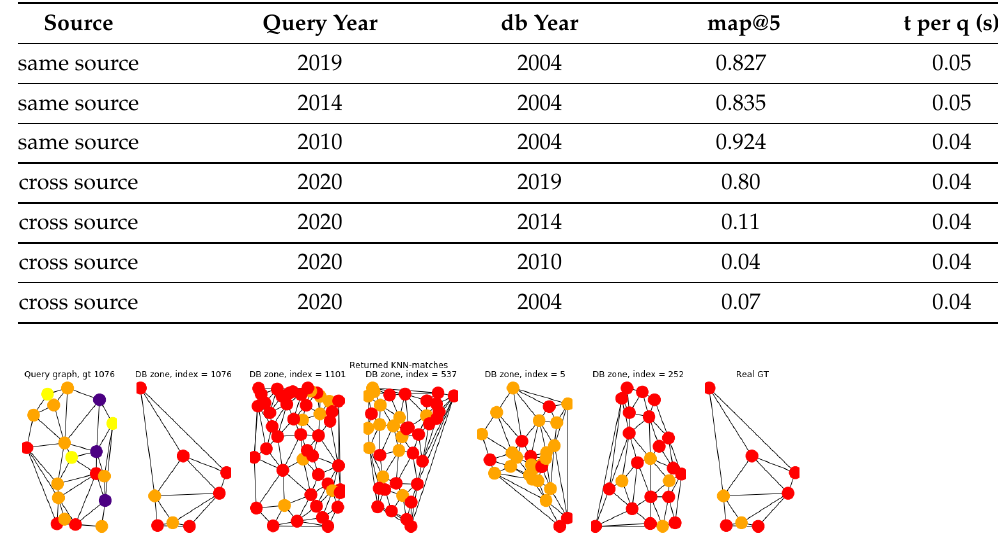
Figure 12. An example of the correct top 5 similar graphs in 2010 returned for the query from 2020, cross source database. The node colors represent the semantics of geographic entities.